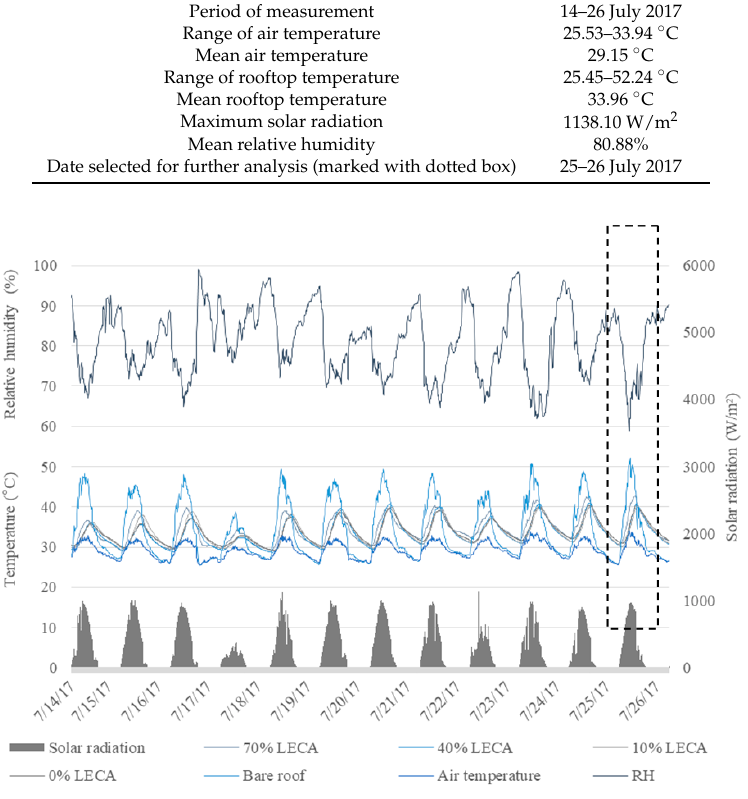
Figure 9. Temperatures, solar radiation, and relative humidity in the cases of 0%, 10%, 40%, and 70% LECA laid at the bottom without plants (14 July 2017 06:00:09 to 26 July 2017 05:50:09).